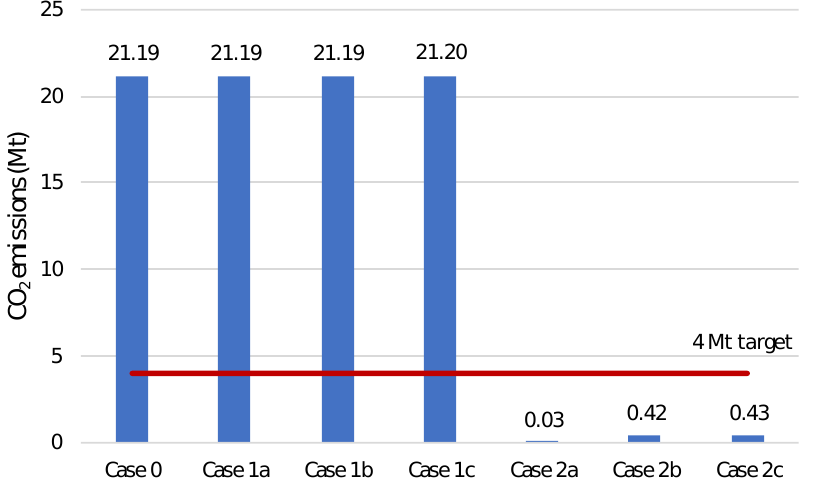
Figure 14. Carbon dioxide emissions for each case study, compared with the 2050 target outlined in Ref.